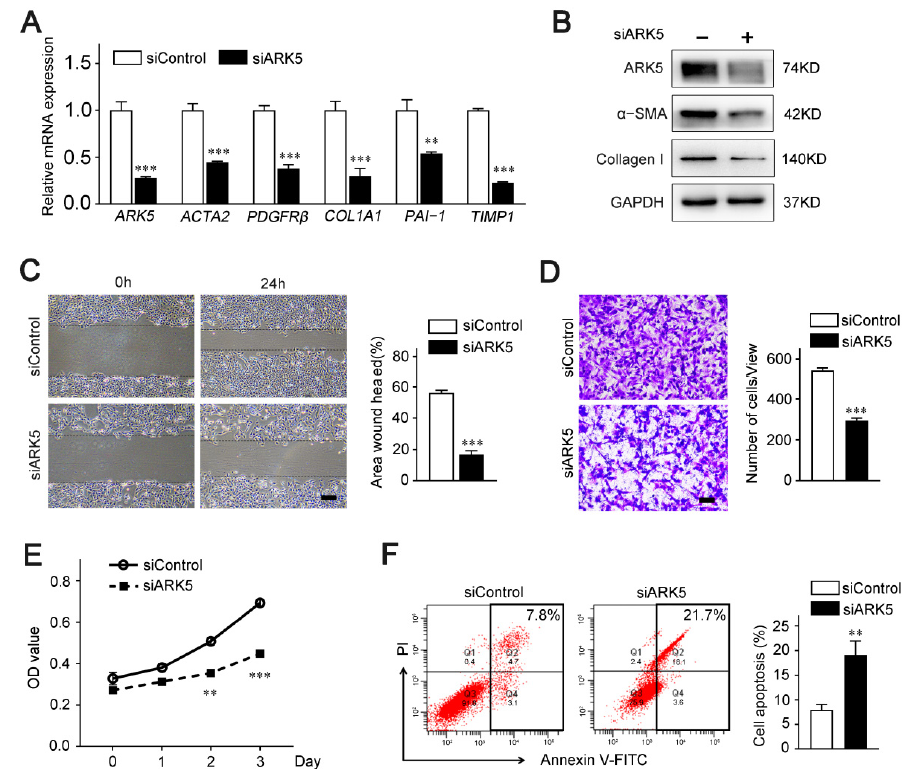
Figure 2. ARK5 promotes HSCs activation, proliferation and survival. ( A ) Quantitative PCR analysis of ARK5 and HSC activation-related genes in the LX-2 cells transfected with siControl or siARK5. ( B ) The expression of ARK5, α -SMA, Collagen I was detected by Western blotting in the LX-2 cells transfected with siControl or siARK5. ( C ) The migration, proliferation and survive capability of LX-2 cells transfected with siControl or siARK5 was measured using the wound-healing assay. Scale bar, 100 μ m. ( D ) The migration of LX-2 cells transfected with siControl or siARK5 was analyzed by the transwell assay. Scale bar, 200 μ m. ( E ) The proliferation capability of LX-2 cells transfected with siControl or siARK5 was measured using the CCK8 assay. ( F ) LX-2 cells were transfected with siControl or siARK5, and the apoptotic cells was examined by flow cytometry. Mean ± SD ( n = 3 per group), ** p < 0.01, *** p < 0.001 versus siControl group. ACTA2, actin alpha 2; PDGFR β , platelet-derived growth factor receptor- β ; COL1A1, collagen type I alpha 1; PAI-1, plasminogen activator inhibitor type-1; TIMP1, tissue inhibitor of metalloproteinase 1; α -SMA, α -smooth muscle actin; V-FITC, annexin-V fluorescein isothiocyanate.